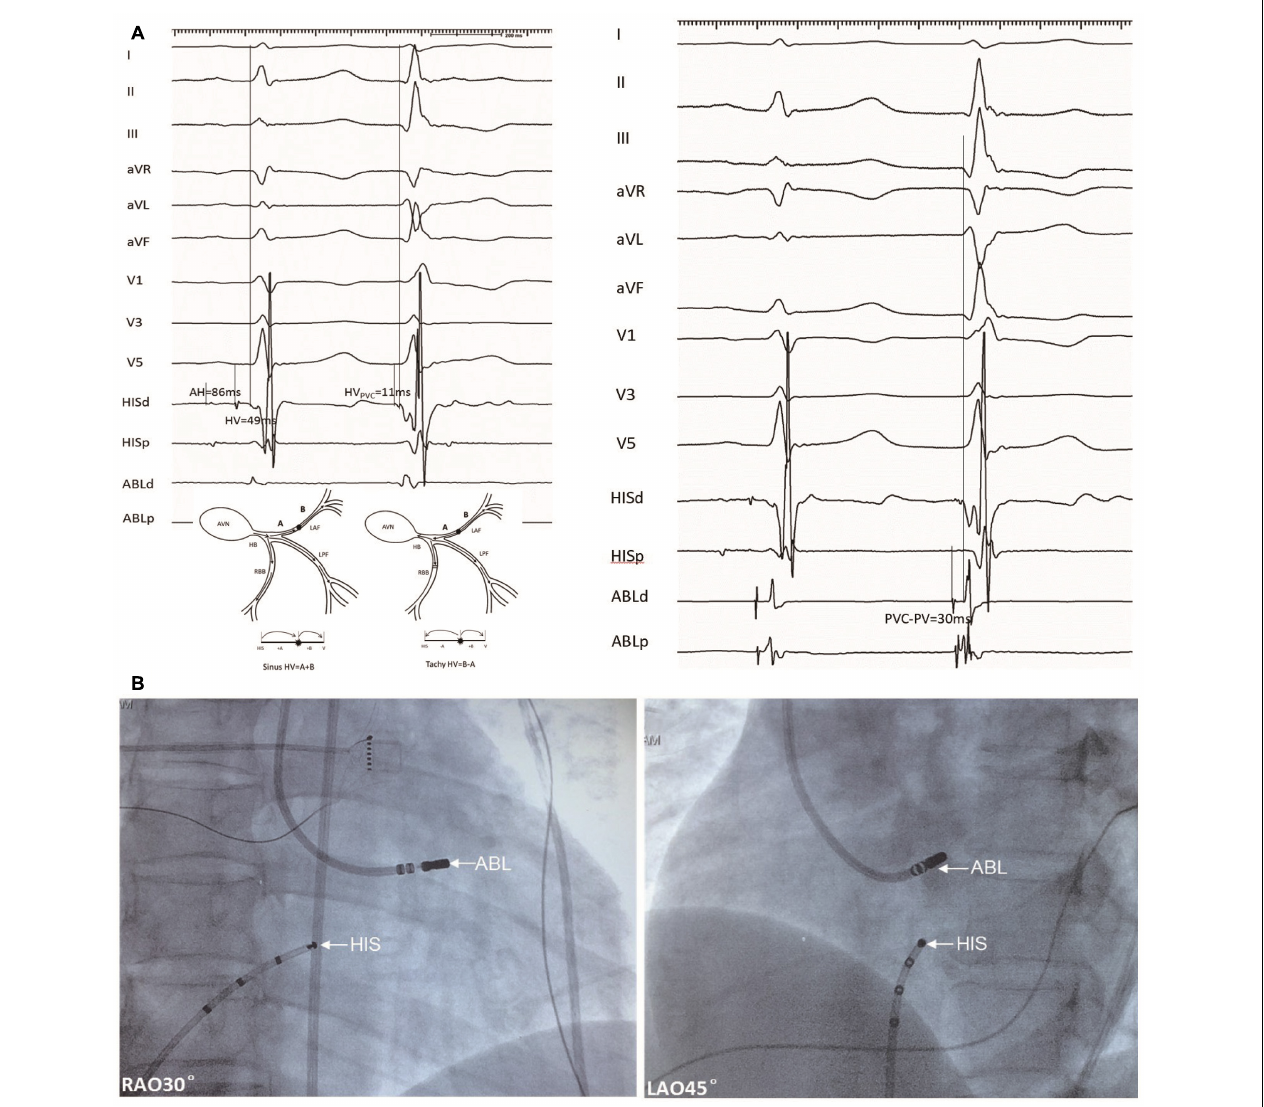
FIGURE 2 | An example of a target ablation site for a PVC originating from the LAF (Patient 18). (A) Left panel, HV intervals during NSR and PVC with mapping electrode positioned at the His bundle were 49 and 11 ms, respectively. Right panel, the catheter was positioned at the target site with a recording interval of 30 ms during PVC between local fascicular potential (PP) and surface ECG, this is equal to the predicted value. (B) Fluoroscopy of LAF-PVC target. PVC, premature ventricular contractions; LAF, left anterior fascicle; NSR, normal sinus rhythm; ABL, ablation electrode; H-V, His bundle to the onset of surface ventricular activation; RAO, right anterior oblique; and LAO, left anterior